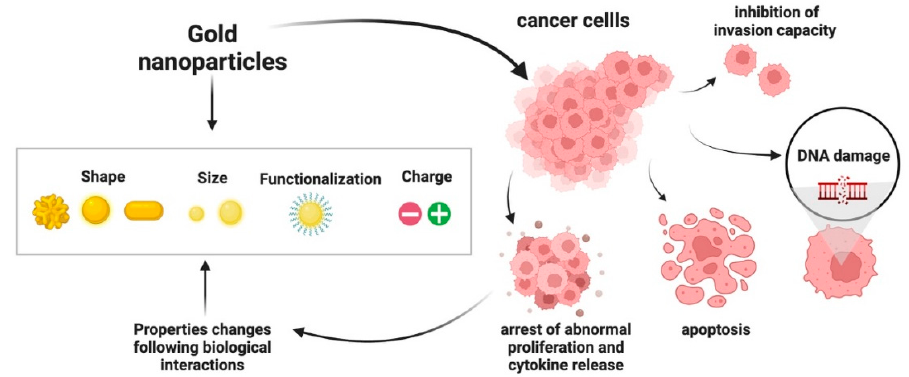
Figure 2. Summary of biological effects by AuNPs on cancer cells created with BioRender.com.